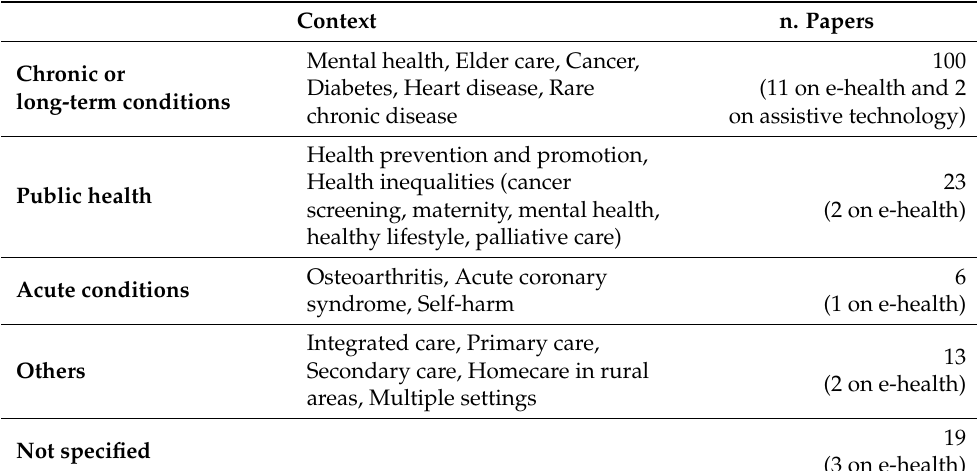
Figure 3. Annual scientific production—health and public. Table 2. Studies’ contexts in the healthcare